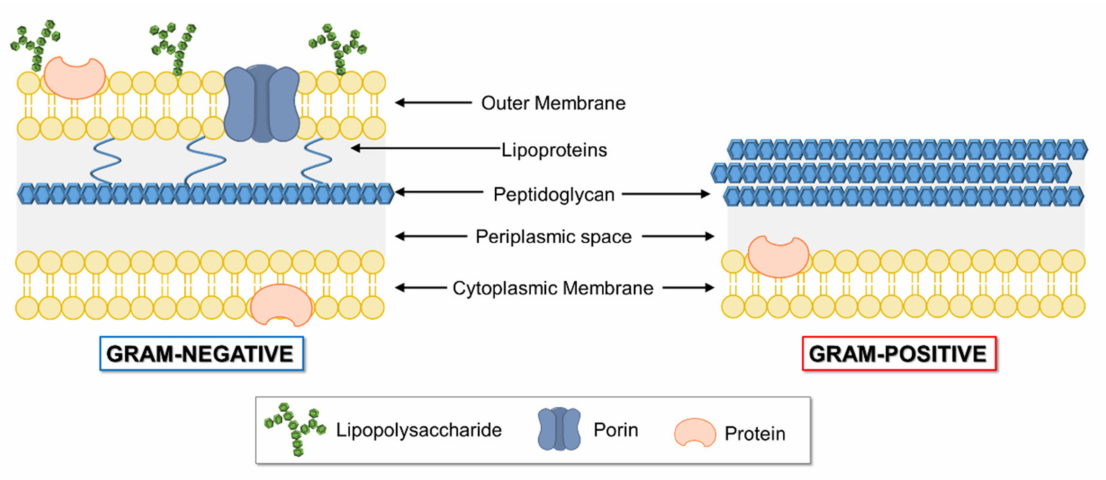
Figure 8. Gram-negative and Gram-positive external